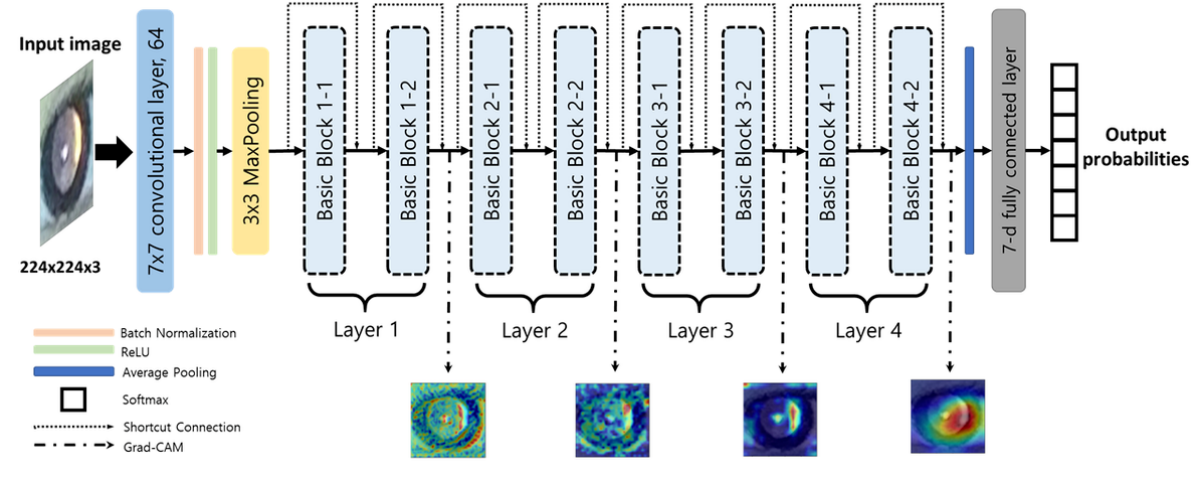
Figure 1. Overview of the proposed deep convolutional neural network architecture. The photorefraction image inputs pass through 17 convolutional layers and one fully connected layer, and the outputs of the network assign the probabilities for each refractive error class given the image. We also generate the localization map highlighting the important regions from the final convolutional feature maps of the layer i (i=1, 2, 3, or